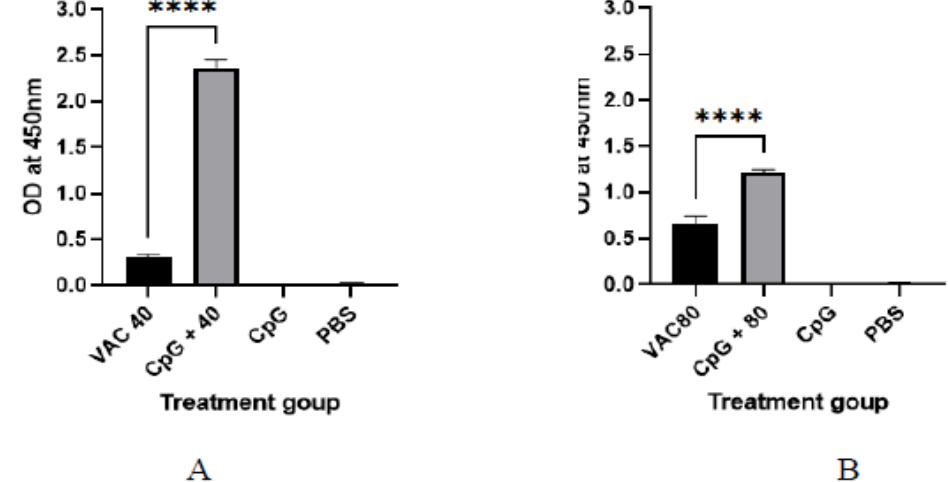
Figure 2. The IgG antibody immune response to SARS-CoV-2 at 28 days after immunization. ( A ) The results of SARS-CoV-2 spike protein-specific IgG antibodies in the plasma of 4 × 10 9 VP of vaccine plus the CpG ODNS group showed statistical significance ( p ≤ 0.001) with a 5.6-fold increase in IgG against 4 × 10 9 VP of vaccine. ( B ) The results of SARS-CoV-2 spike protein-specific IgG antibodies in the plasma of 8 × 10 9 VP of vaccine plus the CpG ODNs group. There was a 1.2-fold increase against 8 × 10 9 VP of the vaccine group. A 95% CI was considered for all tests. (**** p < 0.0001).